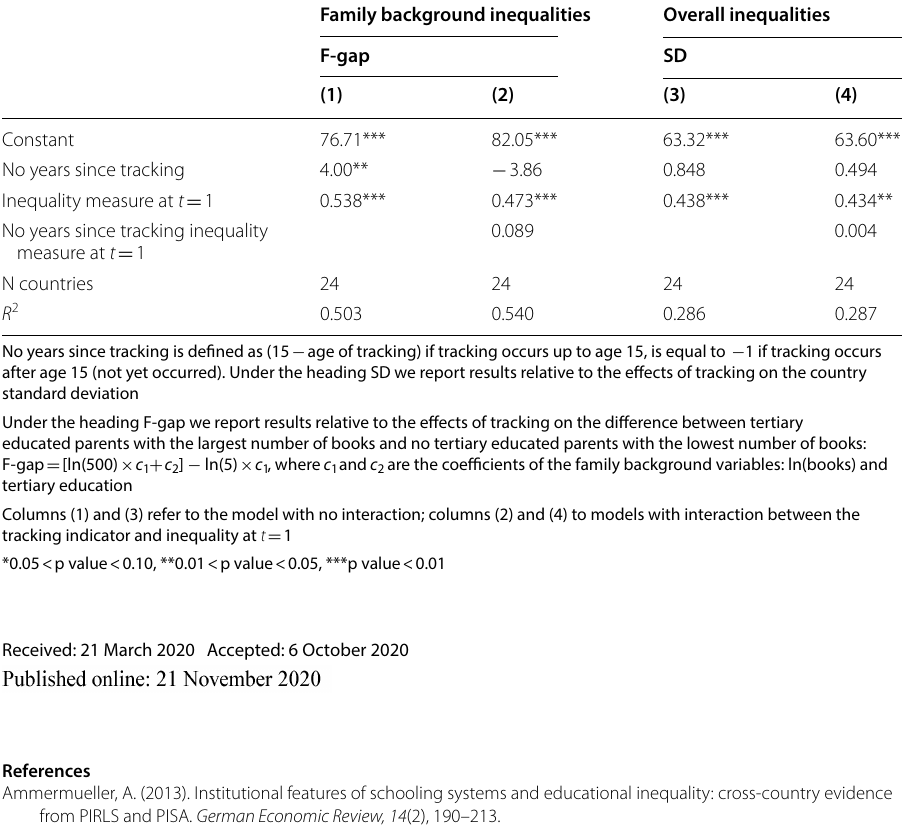
Table 7 Tracking variable: number of years since tracking